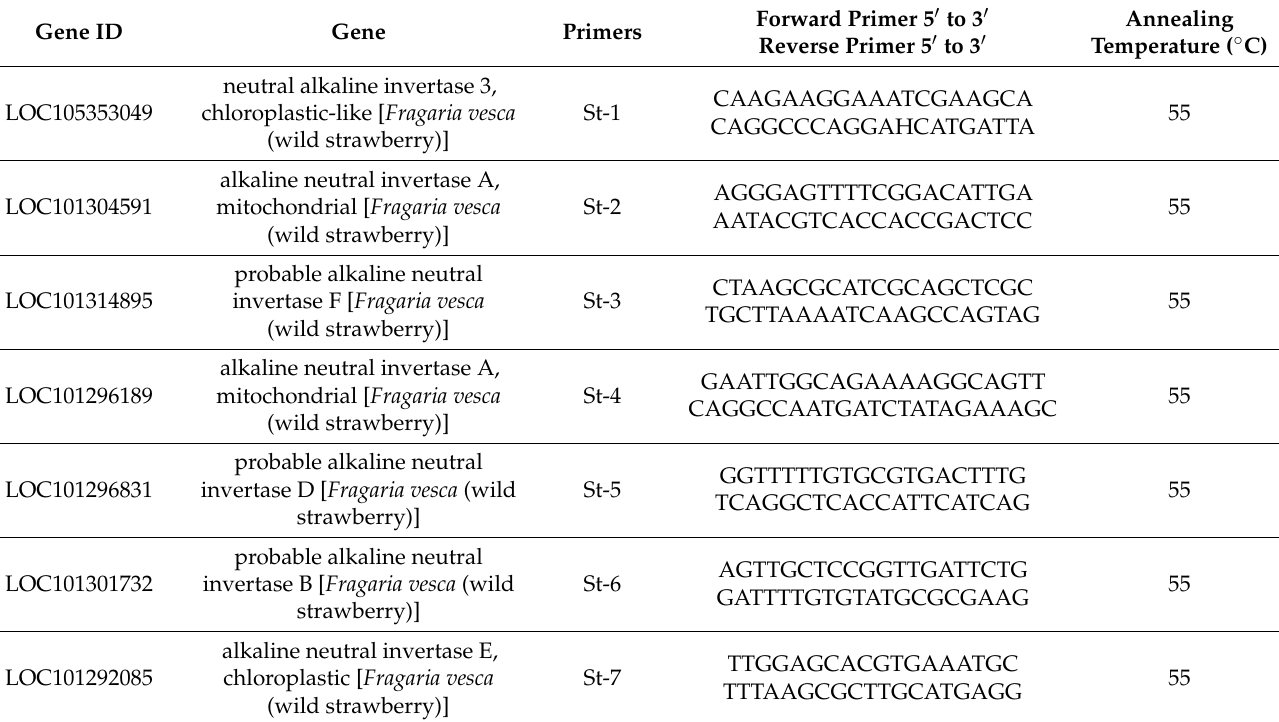
Table 2. Primers, primer sequences and annealing temperatures used for gene